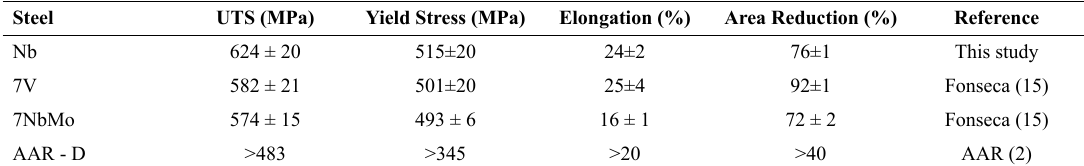
Table 4. Results of tensile test at 538